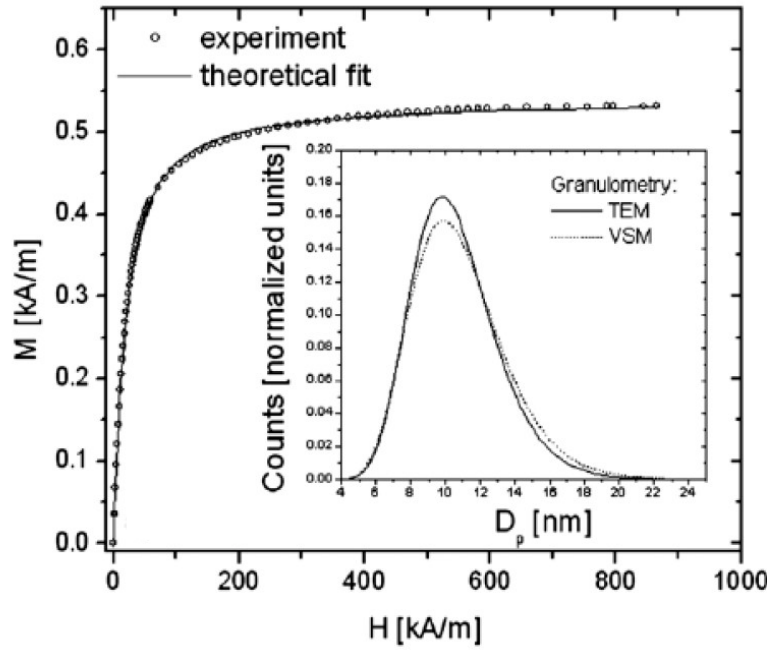
Figure 9. Direct current (DC) magnetization curve and the theoretical fit for a sample of dried magnetic microgels with magnetite nanoparticles. Reprinted with permission from Reference [35].